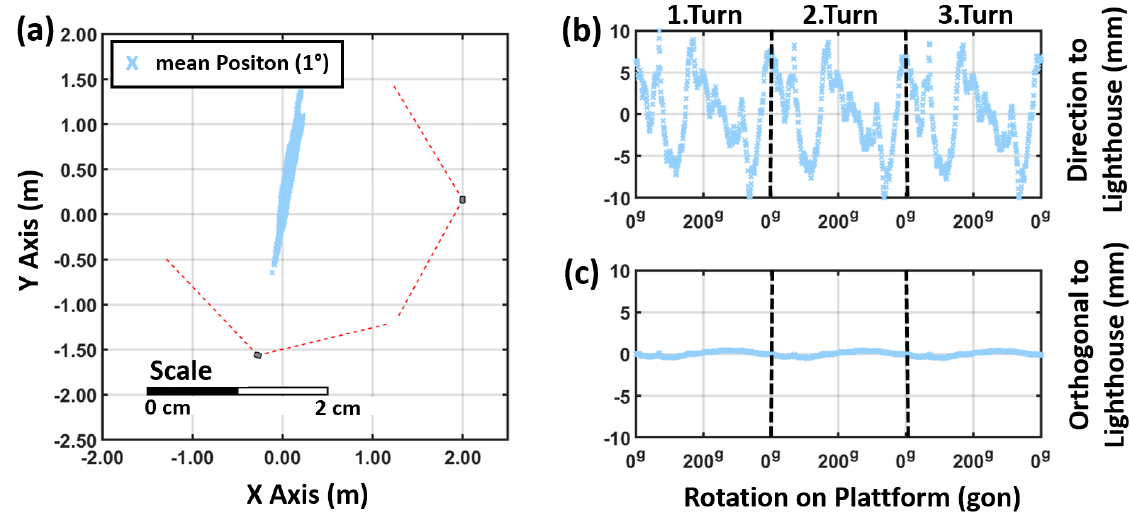
Figure 19. Results of the rotation test for a VR Tracker with two lighthouses ( a ) horizontal plot, ( b ) in direction to the lighthouse and ( c ) in orthogonal